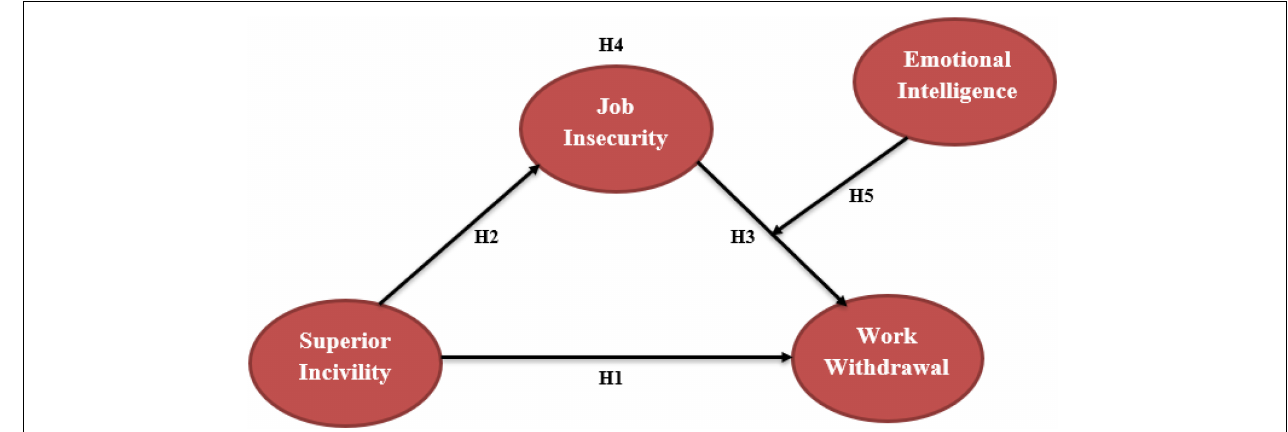
FIGURE 1 | Conceptual model of the study. Source: Author’s